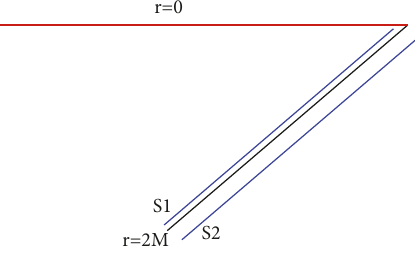
Figure 1: The bold red line is the singularity, and the bold black line, 𝑟 = 2𝑀 , is the horizon. Imagine that 𝑆1 coincides with the horizon, and thus modes located on 𝑆1 are spacelike separated from an observeroutside the black hole.Further,imaginethat 𝑆2 is placed in the vicinity of the